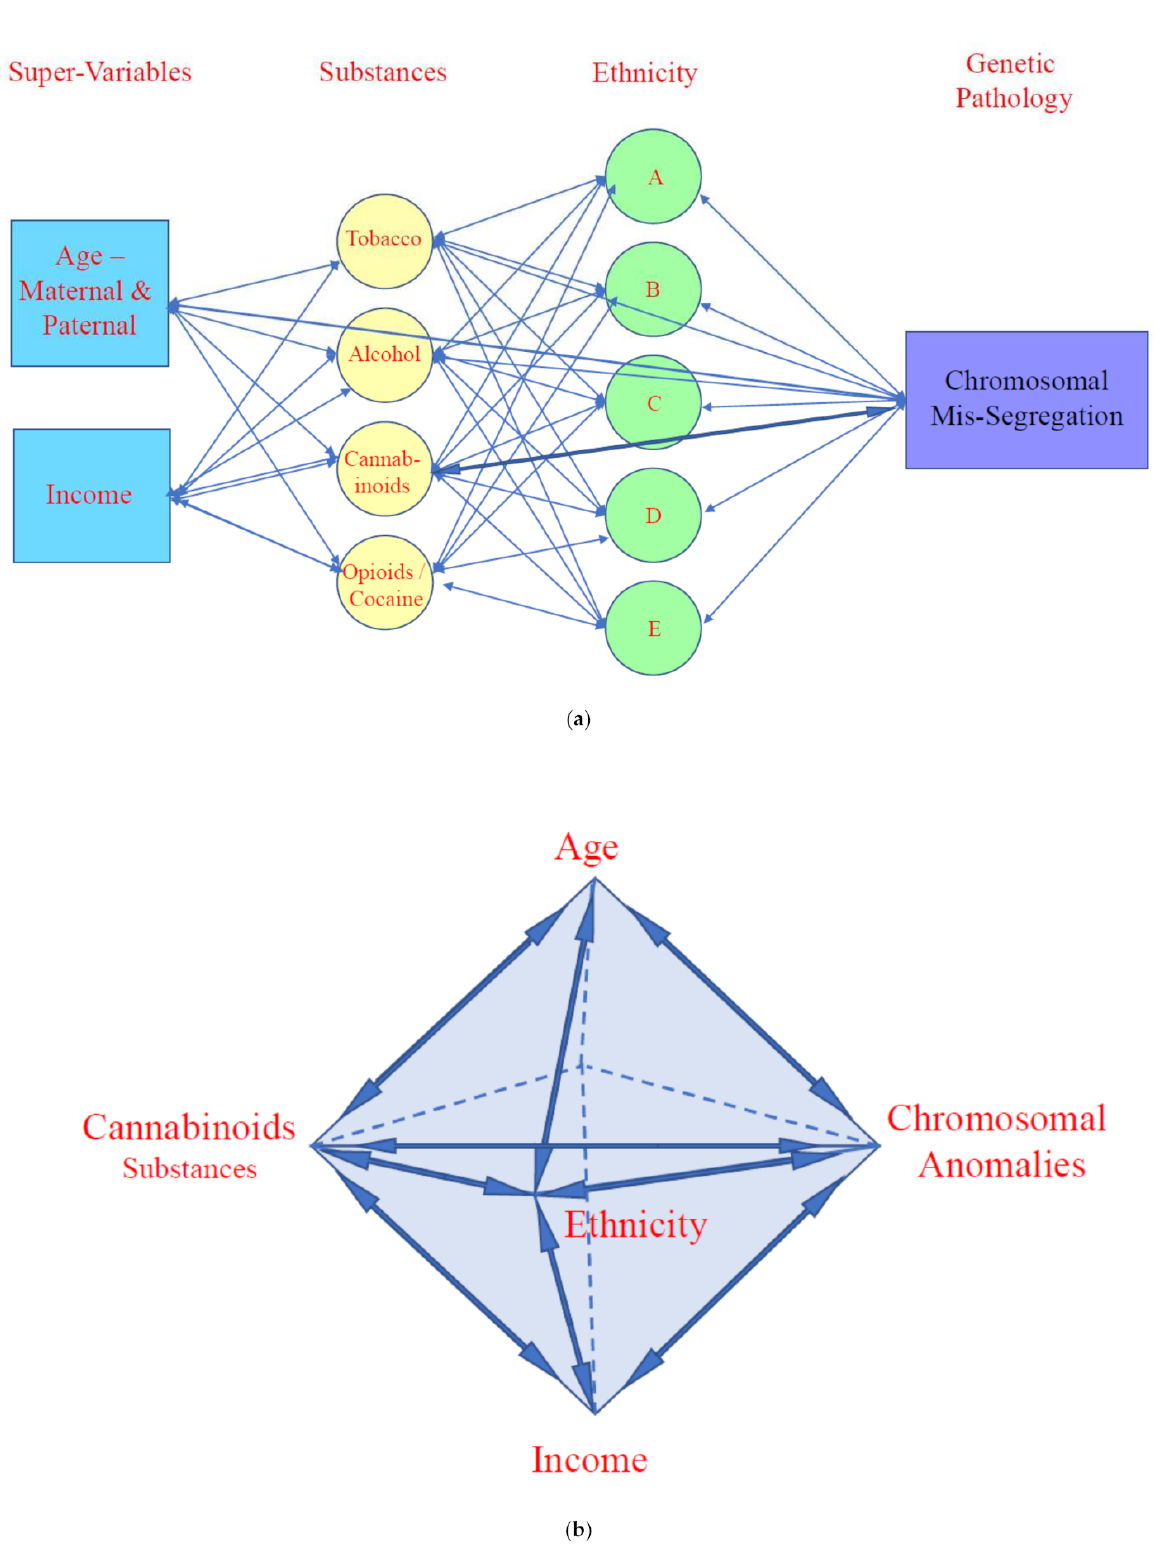
Figure 6. ( a ). Directed Acyclic Graph (DAG) showing presumed causal relationships of covariates in two dimensions (see text for details). ( b ). Three Dimensional Schema representing mutual interaction between four main domains of covariates impacting chromosomal anomalies including direct and indirect effects. Note that each domain impacts the others and the broad and over-arching general effects of age and income